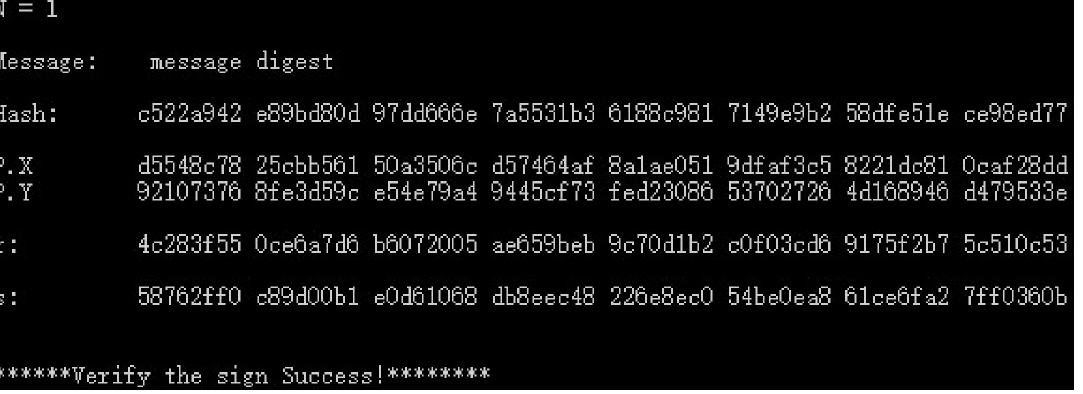
Fig 6. Original SM2 digital signature and verification